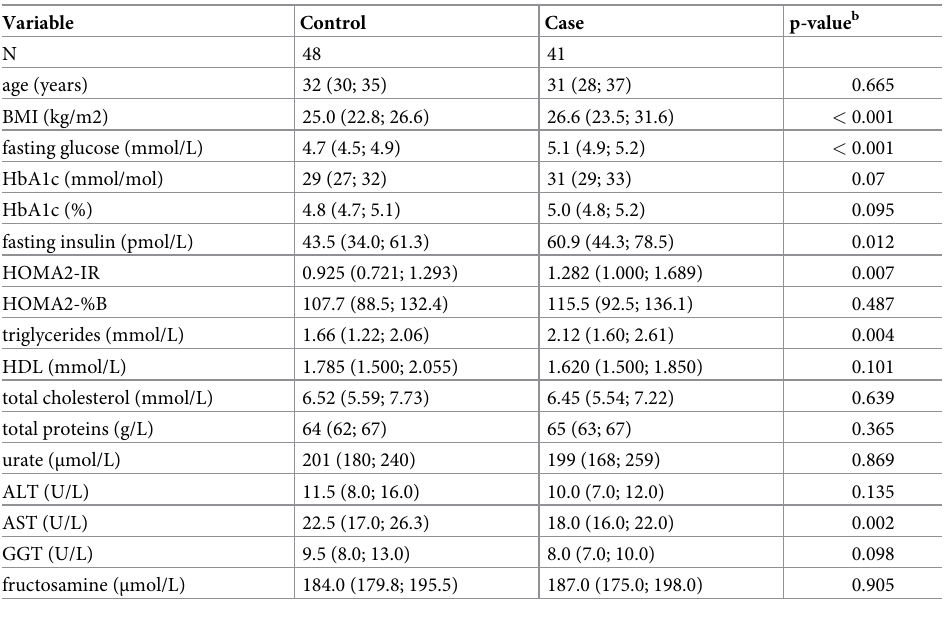
a values are given as median (interquartile range) b p-values were calculated using Wilcoxon rank sum test (significance level α = 0.05)